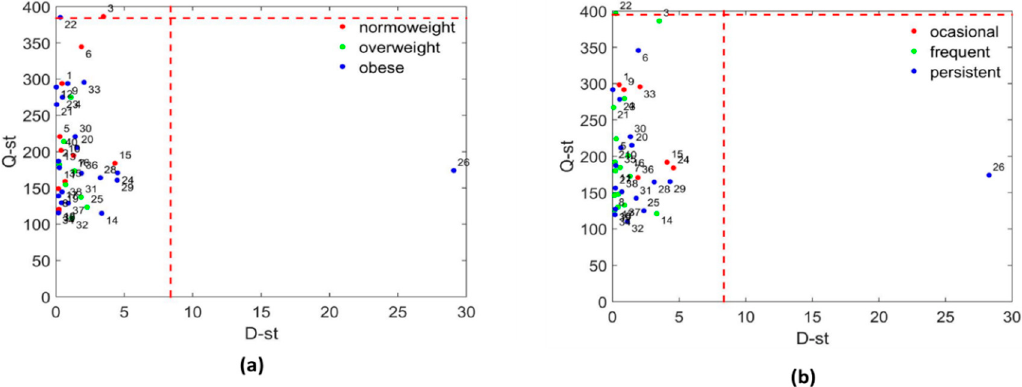
Figure 1. Multivariate Statistical Control Chart based on Principal Components Analysis. Hotelling T2 (D-st) versus the residual sum-of-squares (Q.st). Control limits are shown in red dashed lines. ( a ) Children were classified according to their obese status. ( b ) Children were classified according to asthma severity.